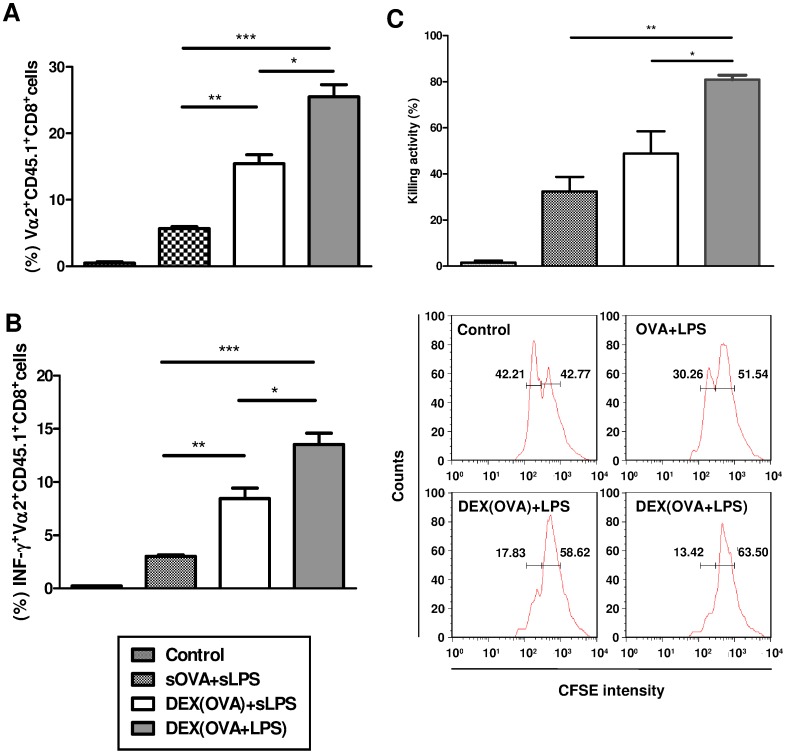
The nanovaccine DEX(OVA+LPS) induces profound activation of antigen-specific CD8+ T cells in vivo.
C57BL/6 mice received CFSE-labeled, OVA-specific OT-I T cells (107) i.v. Two days later, groups of mice (each five animals) were either left untreated or were immunized with OVA (4 µg per mouse), LPS (4 µg), and DEX particle formulations (each 200 µl) as indicated. (A) On day 5, the frequencies of proliferating CD8+CD45.1+Vα2+ OT-I cells were determined in spleen cell suspensions by flow cytometry. (B) In the same experiments, the frequencies of IFNγ+ OT-I T cells were assessed by flow cytometry. (A,B) Data represent mean±SEM of two independent experiments each. The frequencies of proliferating and IFN-γ producing CD8+ OT-I T cells in either group were signifiantly higher than in the non-immunized control group. Other statistical significant differences between groups are indicated (*p<0.05, **p<0.01, ***p<0.001). (C) On day 4 after immunization, mice were injected with CFSElow target cells (loaded with OVA257–264) and CFSEhigh control cells (each 107 cells) derived from syngeneic Ly-5.1+ mice. 4 h later, splenocytes were isolated and frequencies of CFSE-labeled cell populations were assessed by flow cytometry. Upper panel: Data represent mean±SEM of two independent experiments. Statistical significant differences between groups are indicated (*p<0.05, **p<0.01). Lower panel: Frequencies of Ly-5.1+ target cells (CFSElow) and control cells (CFSEhigh) in spleen cell suspensions derived from one mouse of either group are shown as histograms. Graphs are representative of two independent experiments.